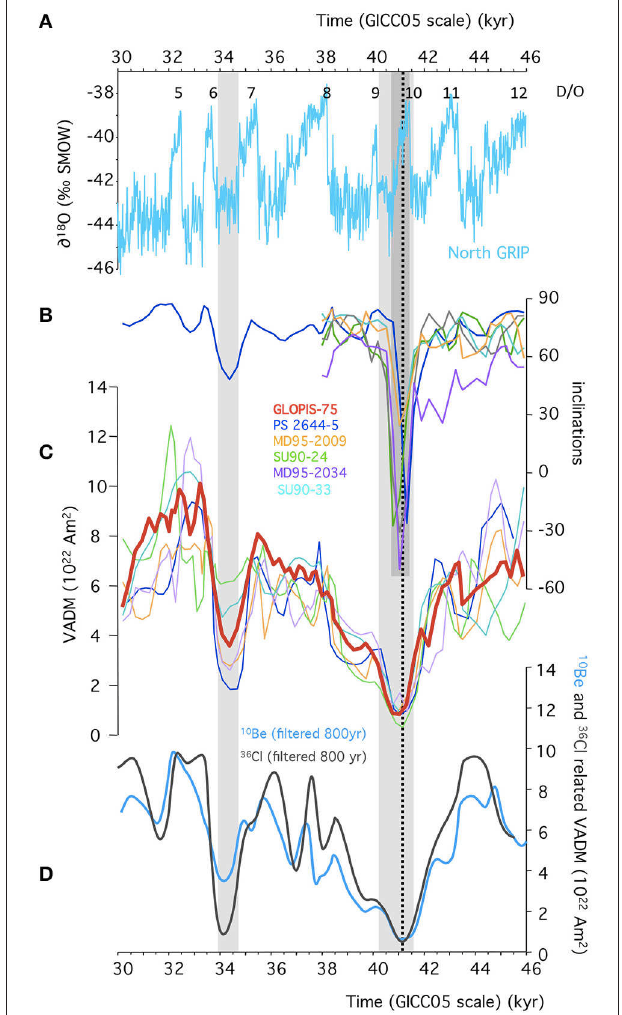
FIGURE 3 | (A) Oxygen isotope record from NorthGRIP ice core (North Greenland Ice Core Project Members, 2004) used as a reference for the time scale. Inclination (B) and paleointensity (C) records of cores from north Atlantic used for NAPIS-75 and also included in GLOPIS-75 stack. Only one of the core (PS2644-5) shows a slight shift in inclination around the Mono Lake excursion. The Laschamp excursion is clearly coeval with the interstadial of Dansgaard-Oeschger (D/O) cycle 10 (Dansgaard et al., 1993) and the Mono Lake excursion is coeval with stadial 7. The light gray bars indicate the time interval characterized by geomagnetic dipole lows and the dark gray bar is for the time interval with negative inclinations during the Laschamp excursion (centered at the vertical dashed line). 10 Be (in turquoise) and 36 Cl (in gray)—derived paleointensity curves from Greenland ice, both filtered at 800 years, are also shown for comparison (D)